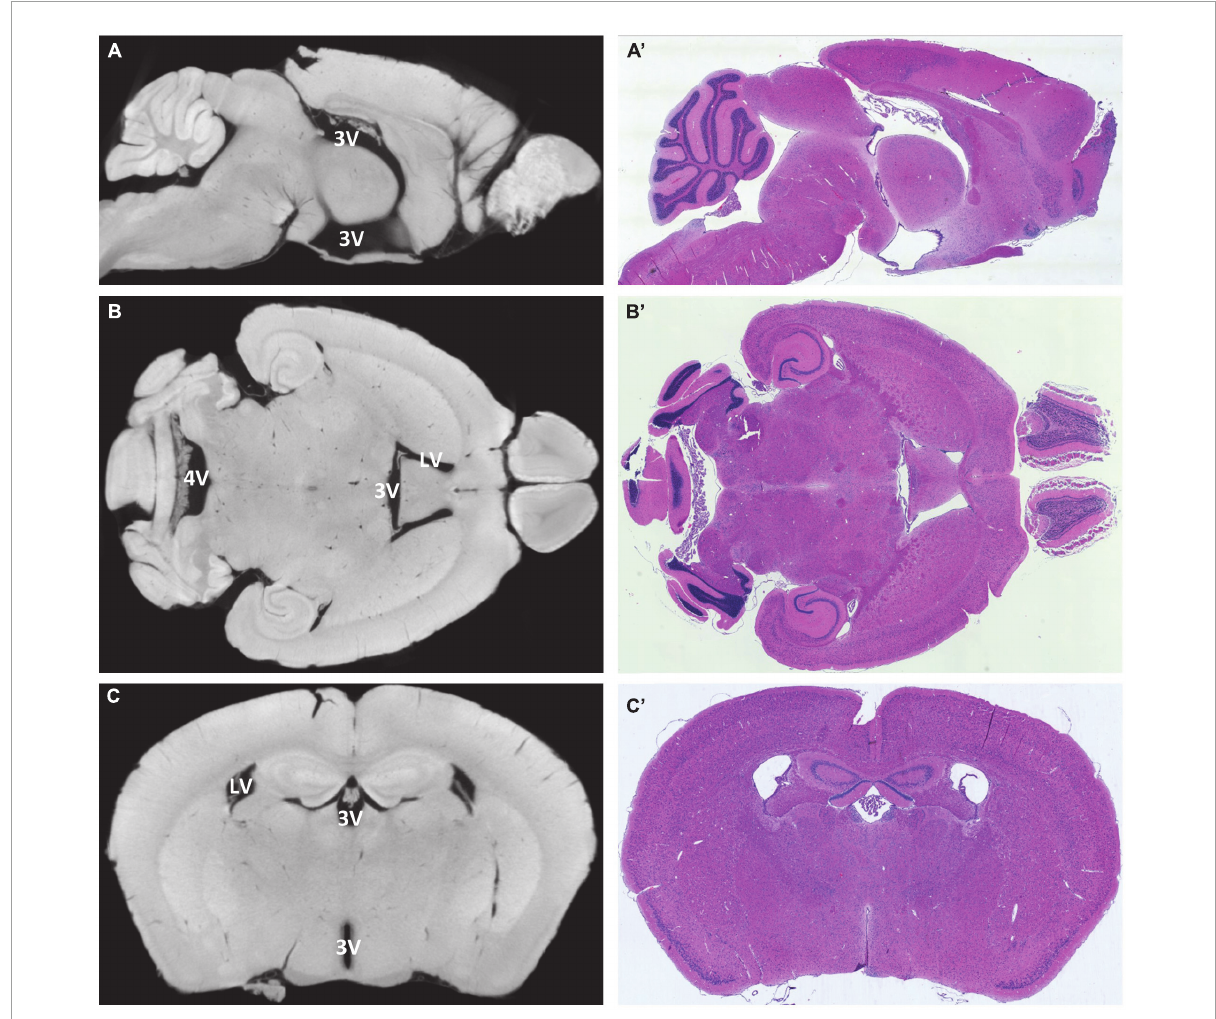
FIGURE2 Alignment of virtual and histological sections. On the left, virtual sections from micro-computed tomography scans, and on the right, hematoxylin-eosin-stained paraffin-embedded sections from the same region and sectional plane. (A,A’) Median section in sagittal orientation, the choroid plexus is visible in the third ventricle and fourth ventricle, lateral ventricles are not visible; (B , B’) horizontal section at the level of the interventricular foramen between the lateral ventricles and the third ventricle, the choroid plexus is visible in all four ventricles; (C , C’) coronal section at the level of the rostral hippocampus with lateral ventricles and third ventricle, the choroid plexus is visible in both ventricles. LV, lateral ventricle; 3V, third ventricle; 4V, fourth